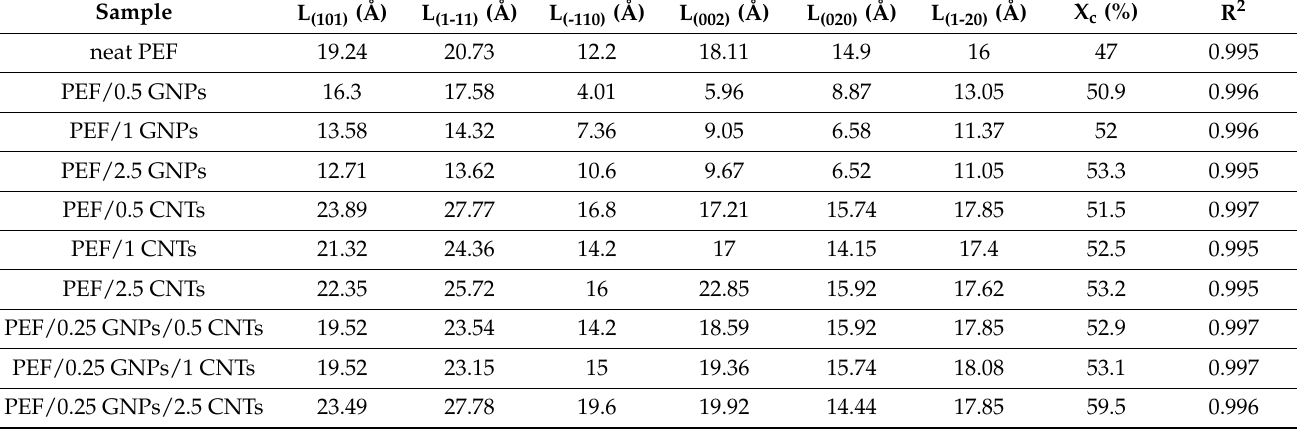
Table 4. The calculated lamellar thickness of the main crystallographic planes and crystallinity degree of neat PEF and PEF/carbon fillers nanocomposites, along with the R 2 values of the fittings.